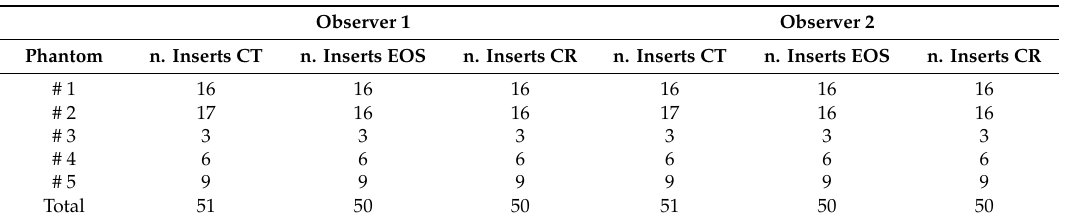
Table 2. Number of inserts detected per phantom on the three imaging modalities by two di ff erent observers who reviewed all images